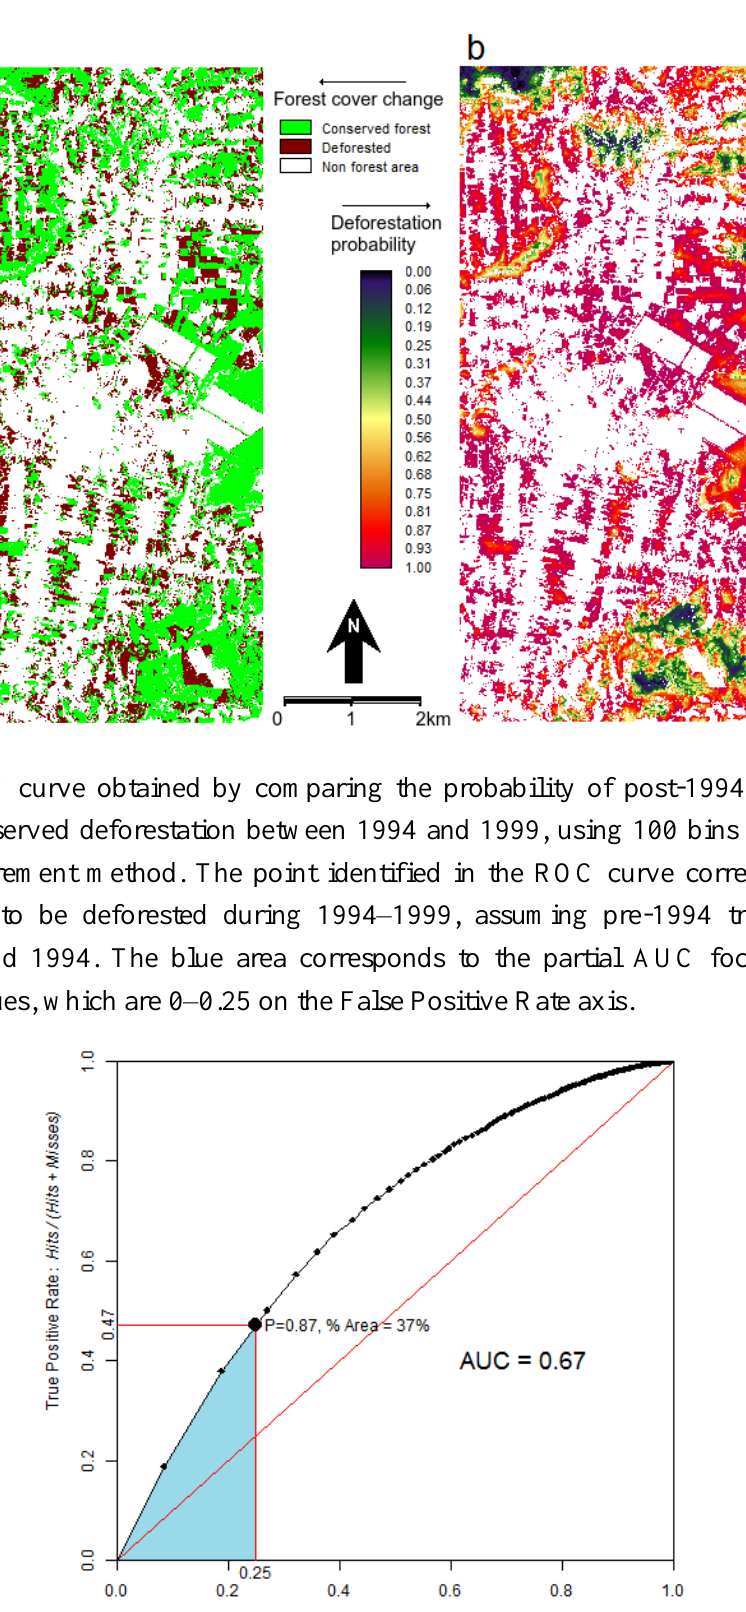
Figure 5. ( a ) Map of observed forest cover change during 1994–1999 and ( b ) probability of post-1994 deforestation. The white non forest areas at 1994 are eliminated from the analysis.